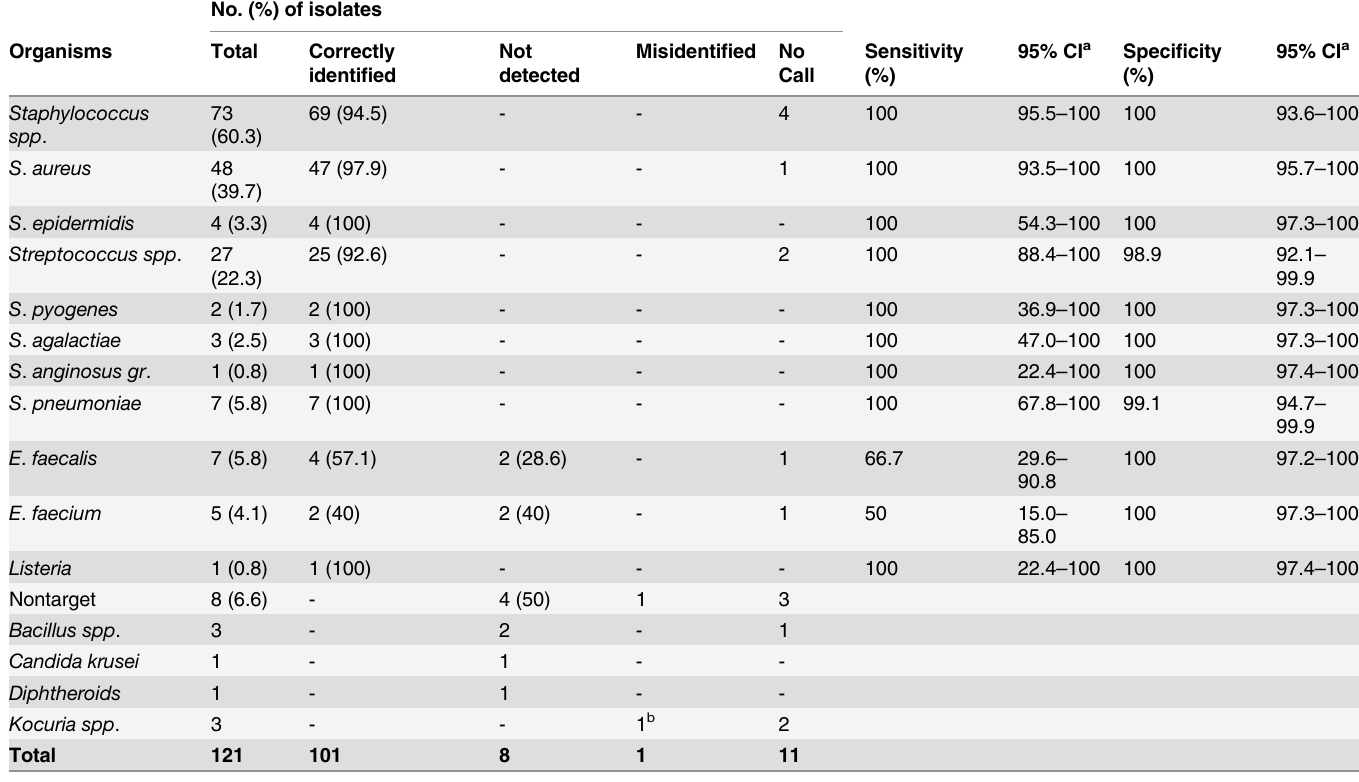
Table 2. Performance of BC-GP for identification of Gram positive